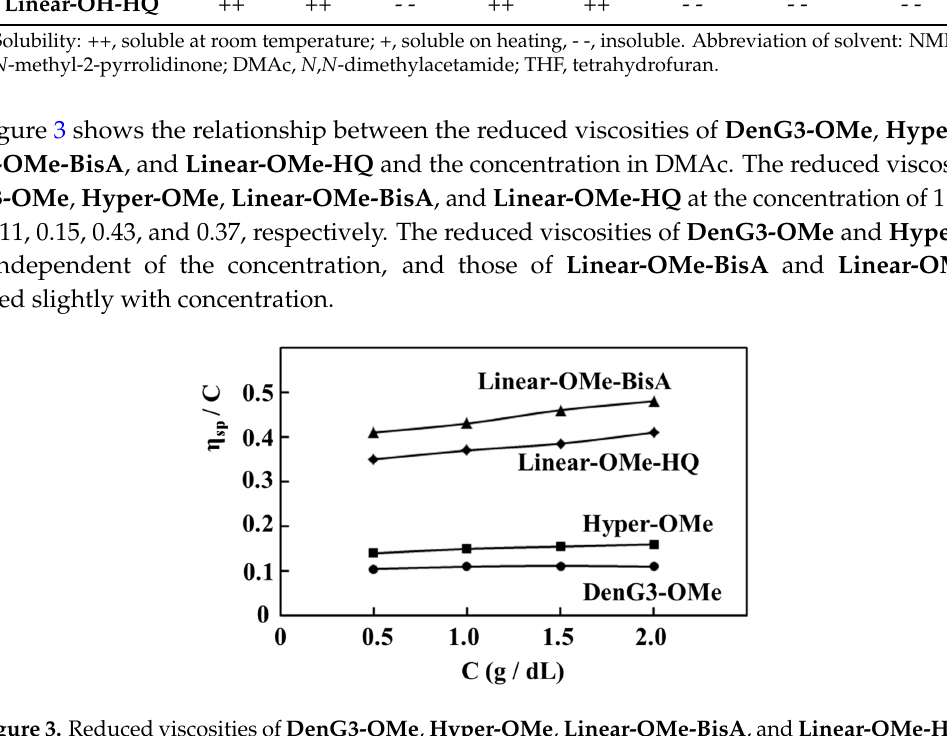
Table 2. Solubilities of DenG3-OH , Hyper-OH , Linear-OH-BisA , and Linear-OH-HQ . Hydroxy Group